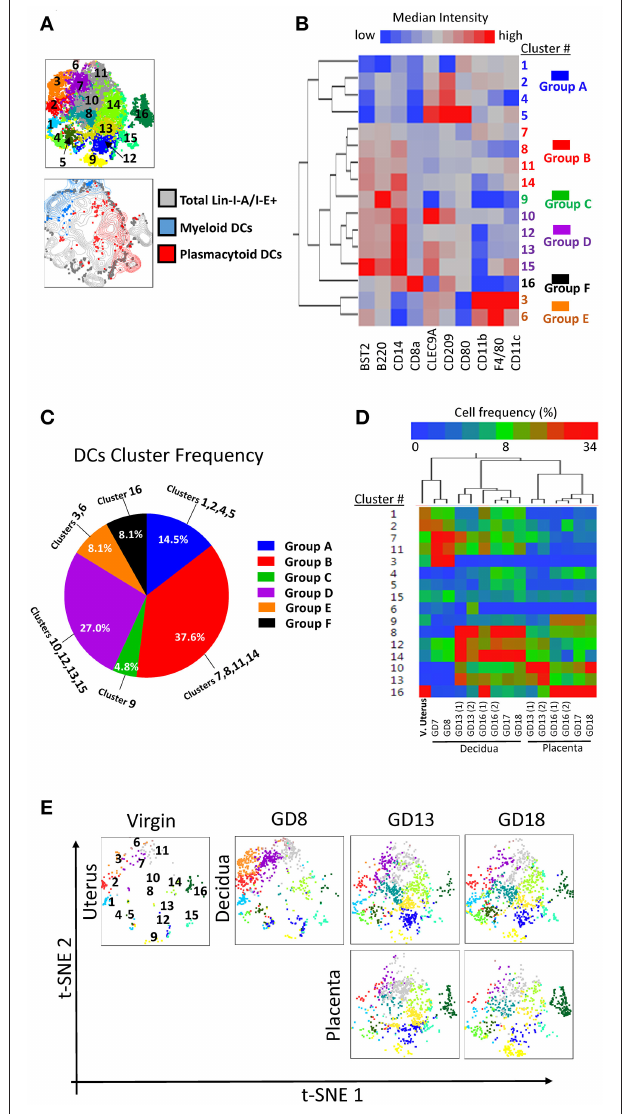
FIGURE 6 | Visualization of dendritic cell diversity. To avoid the cross-batch effect, we used a single experiment including 15 samples of virgin uterus, decidua and placenta across the whole murine pregnancy. (A) t-SNE map generated from pre-gated lin1-I-A/I-E + cells from murine virgin uterus, decidua and placenta across gestational age data sets (top) and manually gated subsets overlaid onto total lin1-I-A/I-E + cells (bottom). (B) Hierarchical clustering of median surface marker expression levels of clusters identified by DensVM. Total of 16 clusters were categorized in 6 groups, group A–F. (C) Pie chart of different group proportions of total DC population. (D) Hierarchical clustering of cluster frequency within lin1-I-A/I-E + from murine virgin uterus, decidua and placenta across gestational age. (E) Separate visualization of cluster in different murine tissues across gestation using t-SNE map generated from the merged data